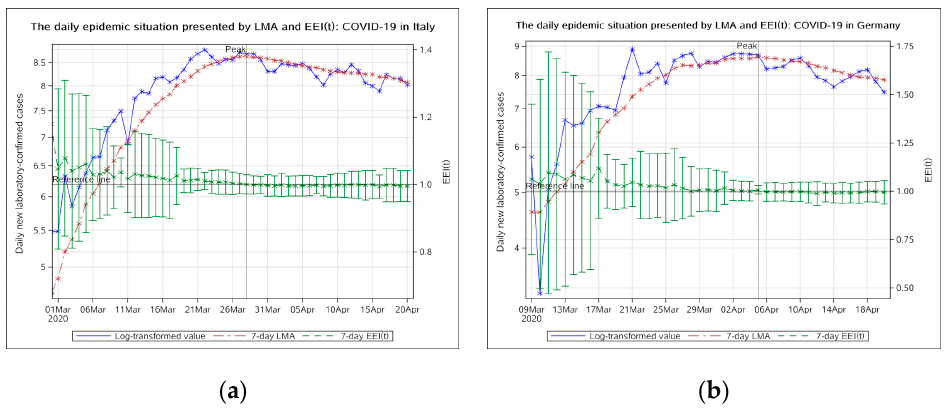
Figure 6. The daily epidemic situation presented by LMA and EEI(t), COVID-19 in Italy ( a ) and Germany ( b ). The blue line indicates the change of the log-transformed value over date. The brown line indicates the change of 7-day LMA over date. The green line indicates the change of the EEI(t) over date. LMA, moving average of log-transformed daily new cases and EEI(t), epidemic evaluation index (t). Eastern Mediterranean